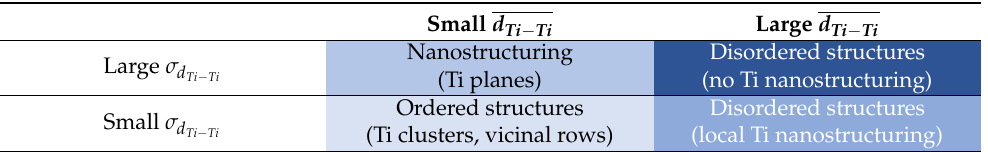
Table 3. Summary of the properties corresponding to different areas of the Figure 3. The darkness of the background corresponds to the level of disorder (darker areas correspond to more disordered structures).